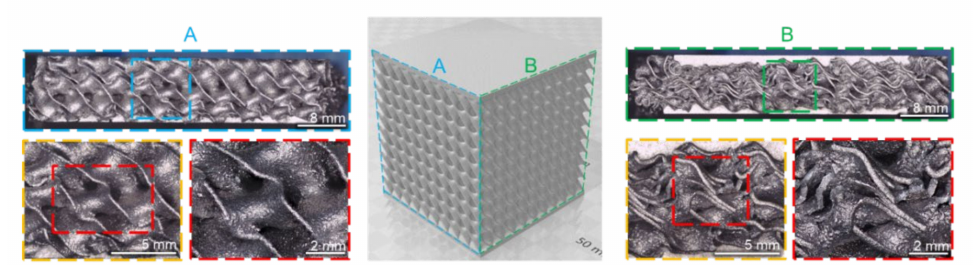
Figure 15. Failure analysis on two surfaces of the diamond TPMS structure for 0.4 mm wall thick- ness/0.13 relative density showing fractured cell